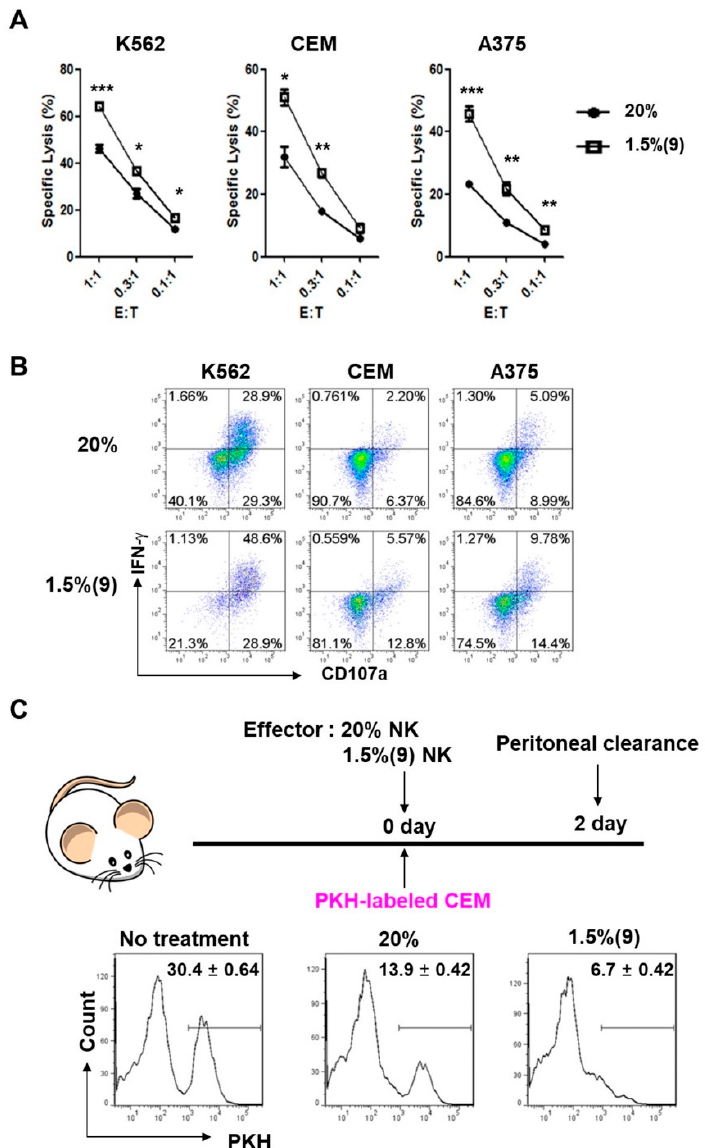
Figure 6. Pre-activated hypoxic NK cells show enhanced cytotoxicity, both in vitro and in vivo. ( A ) Normoxic and pre-activated hypoxic NK cells were assessed for their tumor killing activity using a 51 Cr release assay against K562, A375, and CEM as targets. The data are from three independent experiments, each run “in triplicate”. The percentage of 51 Cr release is shown as the mean ± SEM of triplicates. *, p < 0.05; **, p < 0.01; ***, p < 0.001. ( B ) The level of degranulation and cytokine production of NK cells, in response to K562, CEM, and A375 tumor targets, was assessed by surface CD107a and intracellular IFN- γ -staining. Ex-vivo expanded NK cells, under 18-day normoxic or hypoxic conditions, were used as effector cells, at E:T of 1:1, against tumor targets. Data are representative of three independent experiments. ( C ) In-vivo cytolytic activity of NK cells is shown. A total of 5 × 10 6 CEM tumor cells were labeled with PKH and injected i.p. into 7 to 8-week-old female NSG mice, together with 1 × 10 7 expanded human NK cells (hNK), cultured in both normoxia and hypoxia. After 2 days, the mice were sacrificed, and peritoneal cells were recovered. The three groups of mice received: tumor cells only, tumor cells with normoxic NK cells, or tumor cells with pre ‐ activated hypoxic NK cells. Extent of tumor killing was assessed by comparing the percentage of PKH + cells recovered from peritoneal lavage, with or without NK cell transfer. Data are presented as the mean ± SEM.